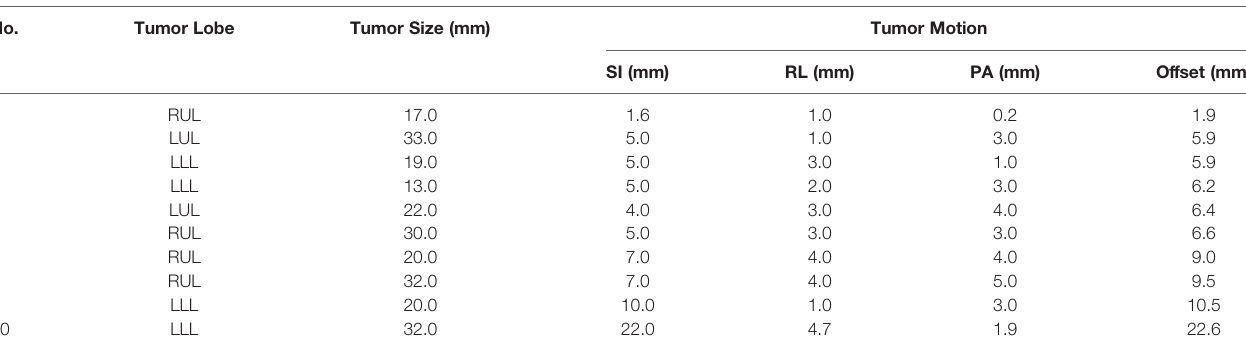
TABLE 1 | Patient